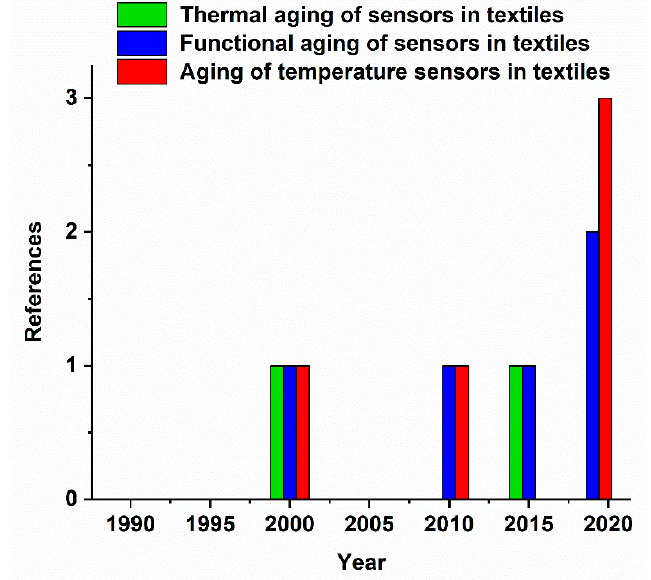
Figure 8. The e ff ects of aging on sensors in Figure 8. The effects of aging on sensors in textiles.